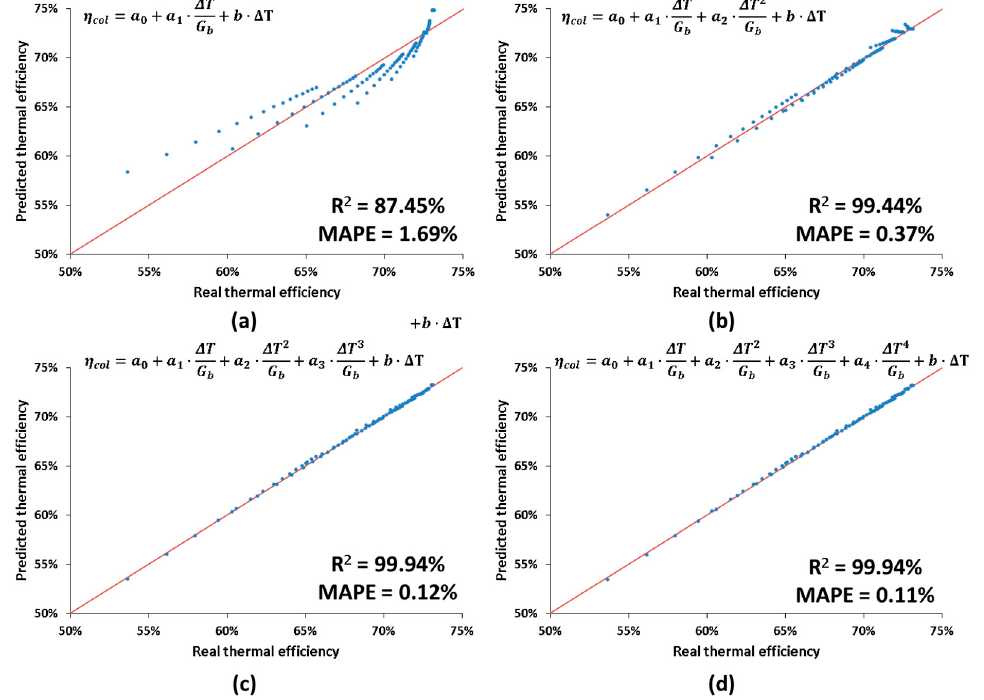
(cid:80) ( a m · ∆ T m / G b ) + b · ∆ T